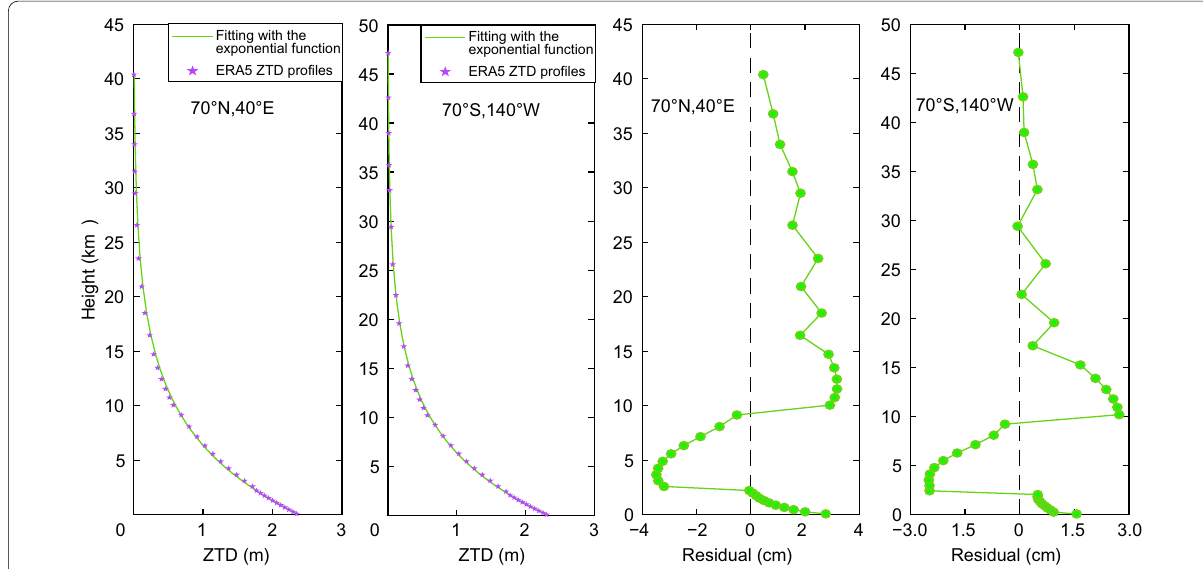
Fig. 1 ERA5 ZTD profiles and cures fitting with the exponential function at two grid points, and the corresponding fitting residual errors of the exponential